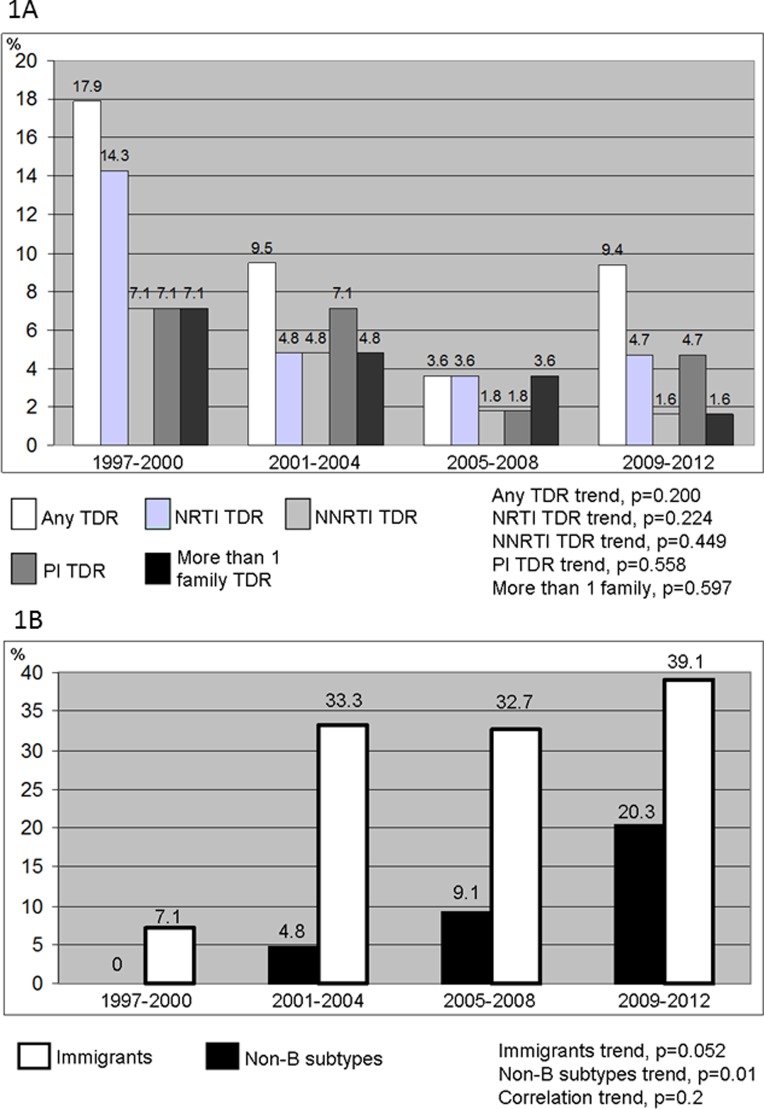
Fig 1A: Prevalence of transmitted drug resistance mutations by study period and drug family according to the 2009 WHO list. Fig 1B: Prevalence of non-B HIV-1 subtypes and immigrants by study period. Footnote figure: NRTI indicates nucleoside reverse transcriptase inhibitor; NNRTI, non-nucleoside reverse transcriptase inhibitor; PI, protease inhibitor.